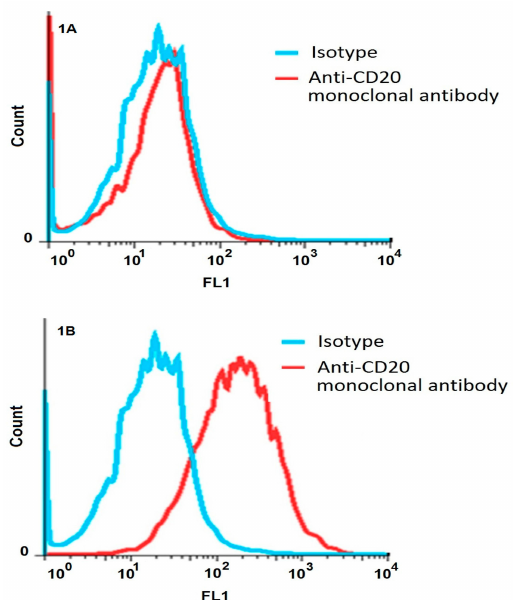
Figure 1. Flow cytometry analysis verified the expression of the CD20 protein on the surface of CD20 + HEK293T cells using Fluorescein Isothiocyanate (FITC)-conjugated anti-CD20 monoclonal antibodies. ( 1A ) lack of expression of CD20 on the surface of HEK293T cell as a negative selection, no difference in fluorescent intensity between isotope and anti CD20 antibody; ( 1B ) Over-expression of CD20 on transfected CD20 + HEK293T cells was shown. Fluorescent light channel 1